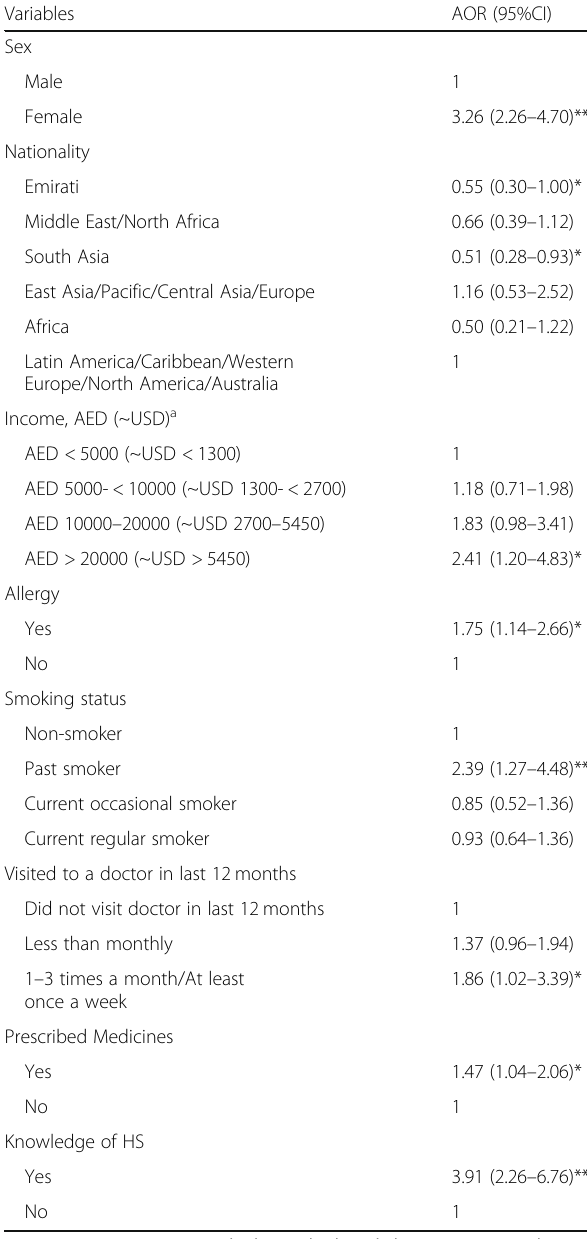
product and dietary supplement consumption patterns. Table 3 Adjusted odds ratios for HS use in Dubai, 2015 ( n = 1203)